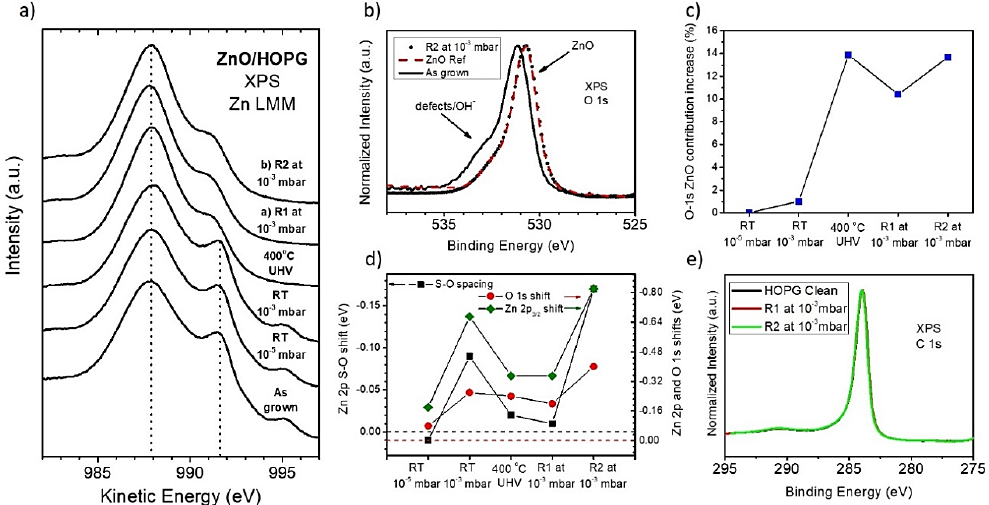
Figure 4. ( a ) Auger Zn LMM XPS spectra as a function of the thermal treatment; ( b ) normalized XPS O 1 s spectra for as grown ZnO/HOPG sample and after different thermal treatments; ( c ) O–Zn component increase for the O 1 s spectra as a function of the thermal treatment; ( d ) S–O splitting (black square, left axis) and O 1 s and Zn 2 p 3/2 shifts (right axis, red circle and green rhombuses, respectively) as a function of the thermal treatment; ( e ) normalized XPS C 1 s spectra for clean HOPG and ZnO/HOPG samples after different thermal treatments.